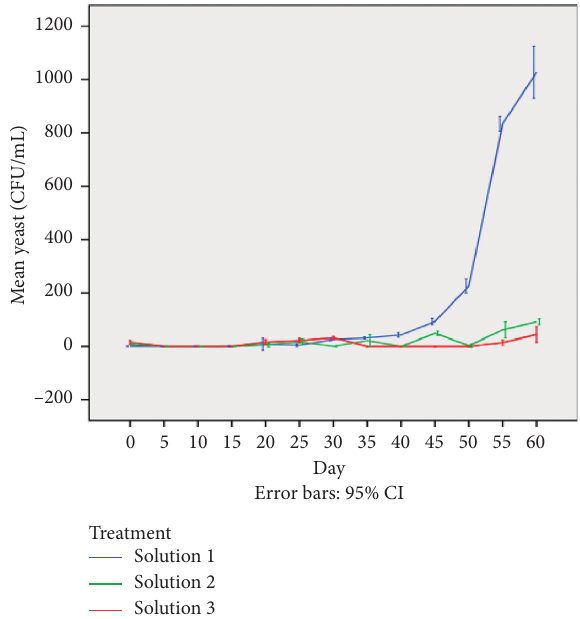
Figure 4: Changes (means ± SD) in yeast count of antimicrobial edible coating solutions: solution 1 (0.250 g/L Delvocid), solution 2 (0.275 g/L Delvocid), and solution 3 (0.300 g/L Delvocid) during the storage at 8 ° C and 85% RH.